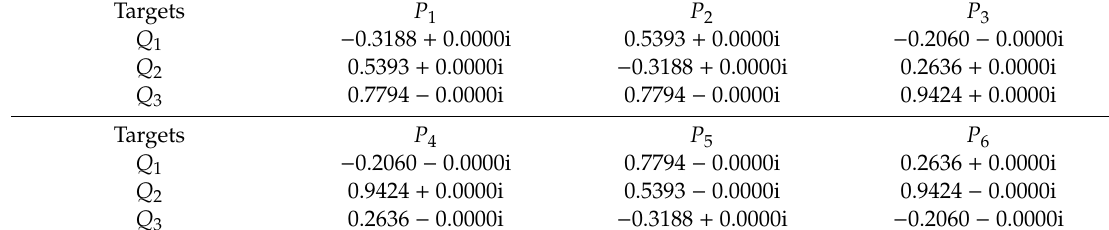
Table 5. Complex coe ffi cients of di ff erent false targets corresponding to three transponders.